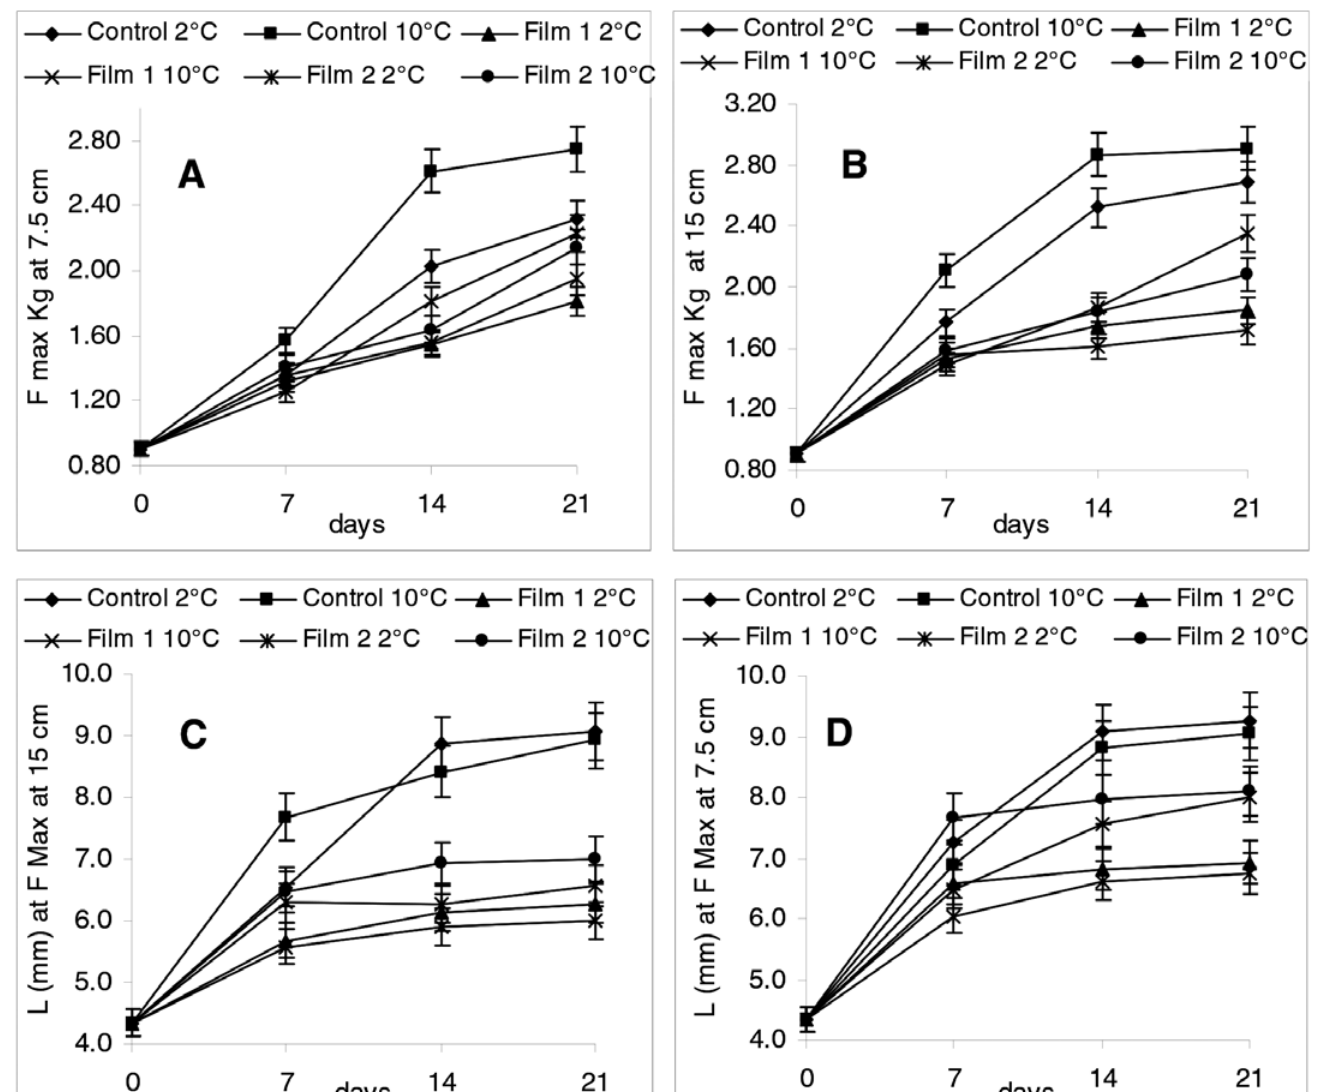
Fig. 3 - Effect of film packaging (Control, un-packaged; Film 1, Omnifilm PVC film; Film 2, Bolphane BX polyolefinic film) and storage conditions (2°C and 10°C) on cutting force (F max) and force displacement (L at F max) in green asparagus during 21 days of storage at 7.5 cm (A and C) and 15 cm (B and D) of the tip. Vertical bars represent the standard deviation. LSD are given at the 5%